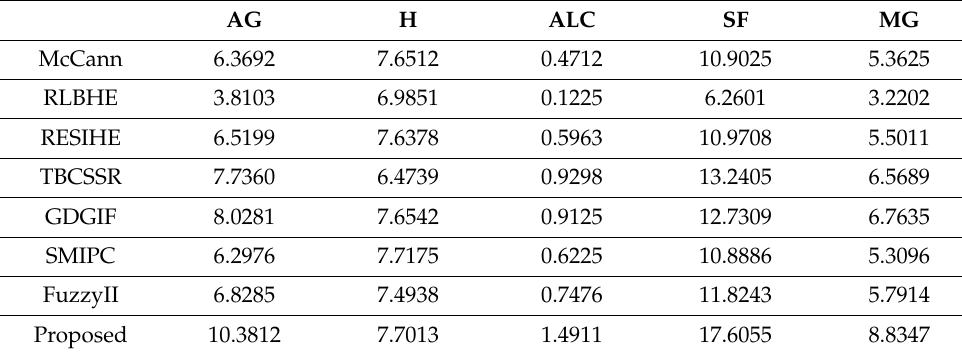
Table 1. The metric data of eight methods on X-ray image